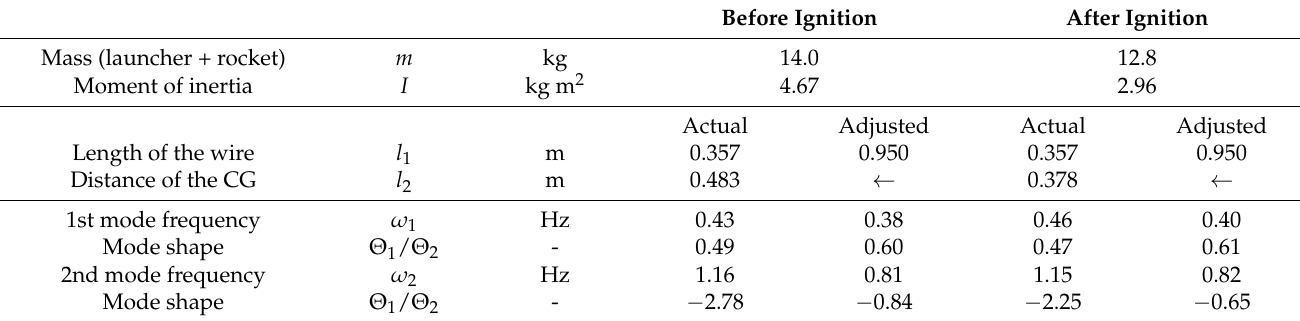
Figure 7. Double pendulum mode shapes. Table 1. Structural properties and mode parameters.